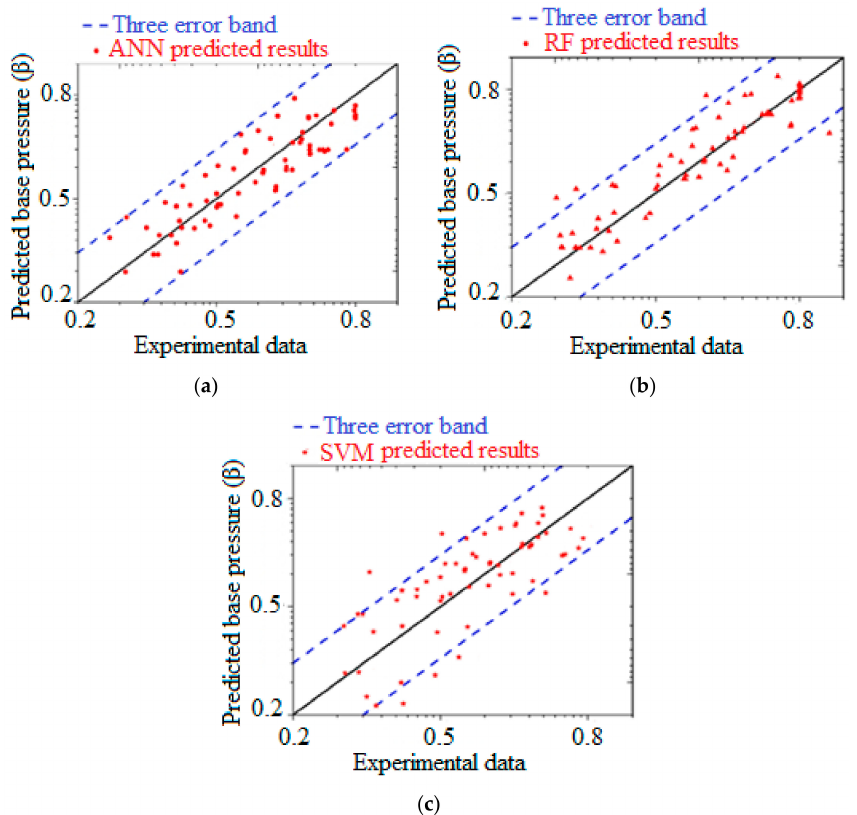
Figure 7. ( a ) Variation of ANN predicted results against experiments, in which all data points lie